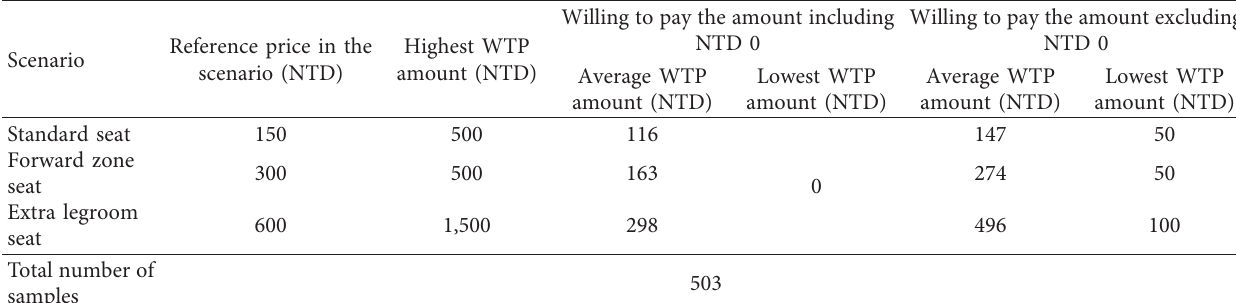
Table 6: Average WTP the fees in the questionnaire